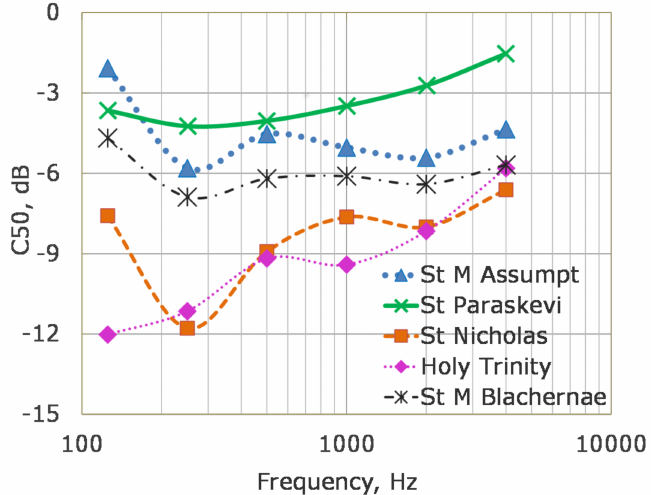
Figure 16. Measured results of clarity index (C 50